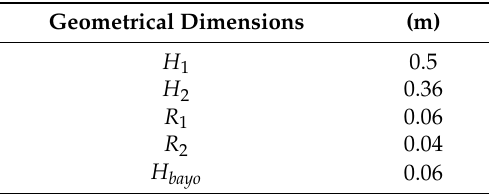
Table 1. Nominal target dimension (see Figure 1).